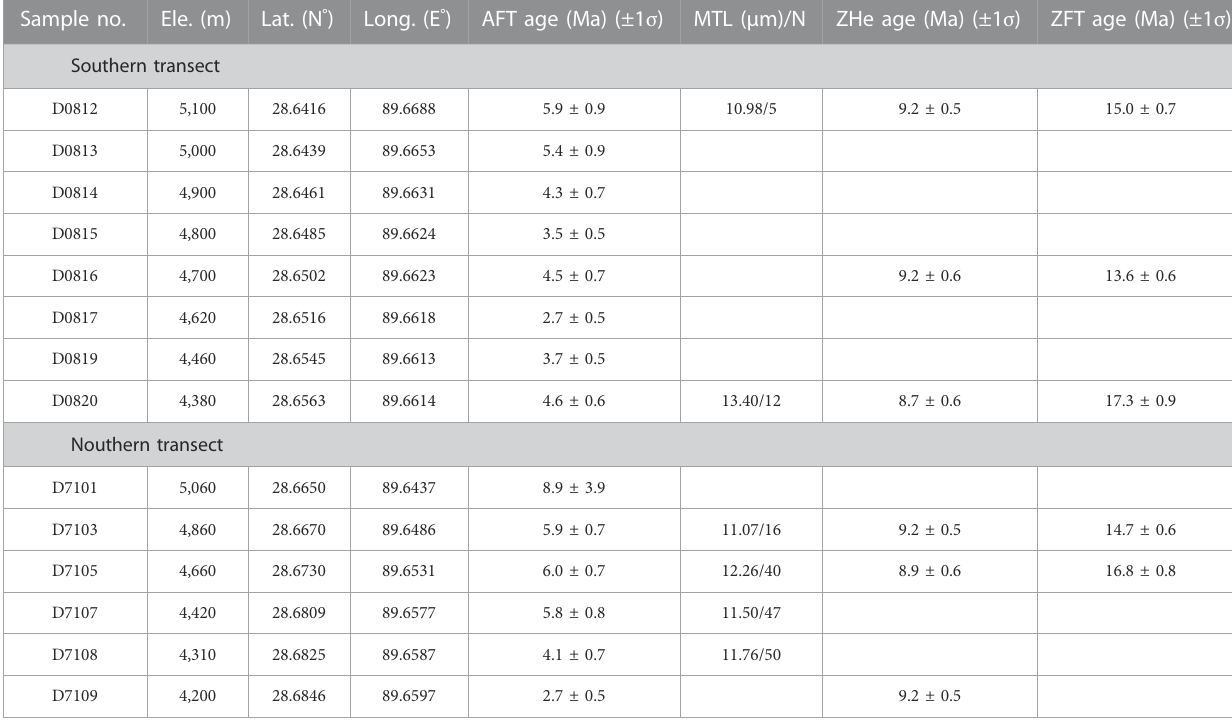
TABLE 1 Summary of new AFT, ZHe, and ZFT data reported in this study. Sample